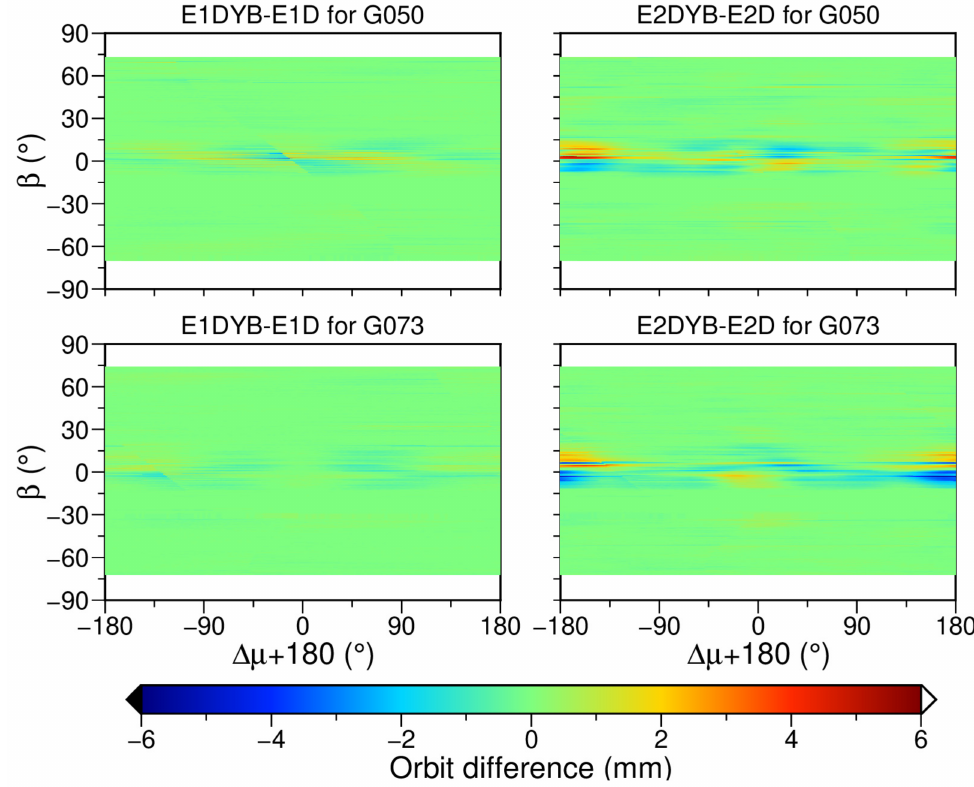
Figure 8. Differences of satellite orbits in the radial component caused by applying the shadow factor in the D and DYB directions for SVN G050 (BLOCK IIR, upper panels ) and G073 (BLOCK IIF, lower panels ) as a function of β and ∆ µ angle in 2019. ∆ µ is the angular argument. Left and right: using ECOM1 and ECOM2 as parameterization SRP models,